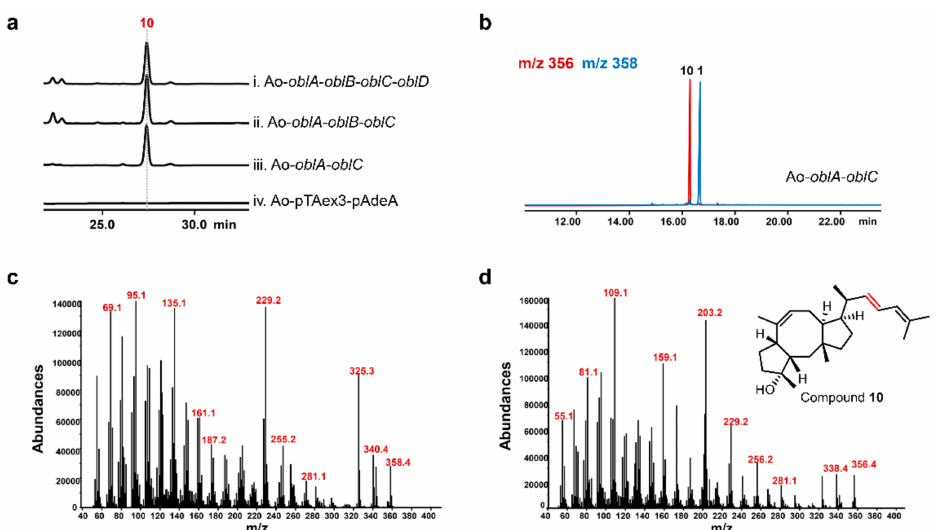
Figure 4. Functional characterization of OblC Au . ( a ) HPLC detection of crude extracts of A. oryzae expressing oblA Au - D Au . ( b ) GC-MS analysis of extracts from Ao- oblA Au - oblC Au . ( c ) MS spectra of m/z 358 was extracted. ( d ) MS spectra of m/z 356 was